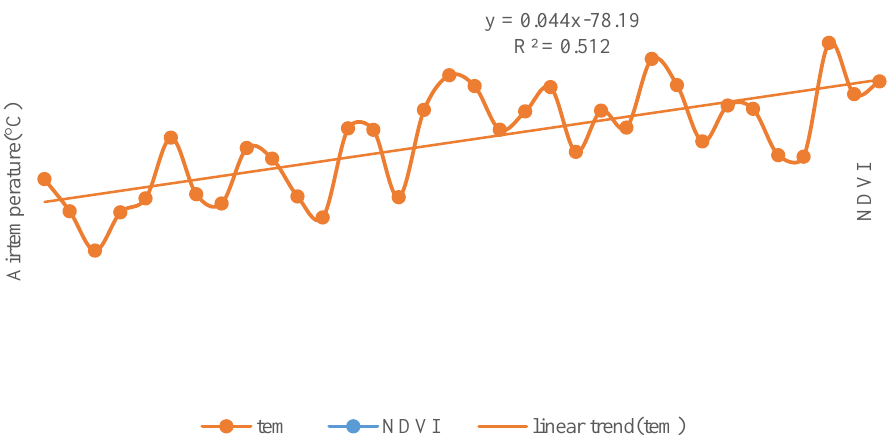
Figure 9. Variation curve of NDVI and annual mean temperature in Shaanxi Province during 1982–2015 (“tem” denotes the temperature. The x -axis represents the year).